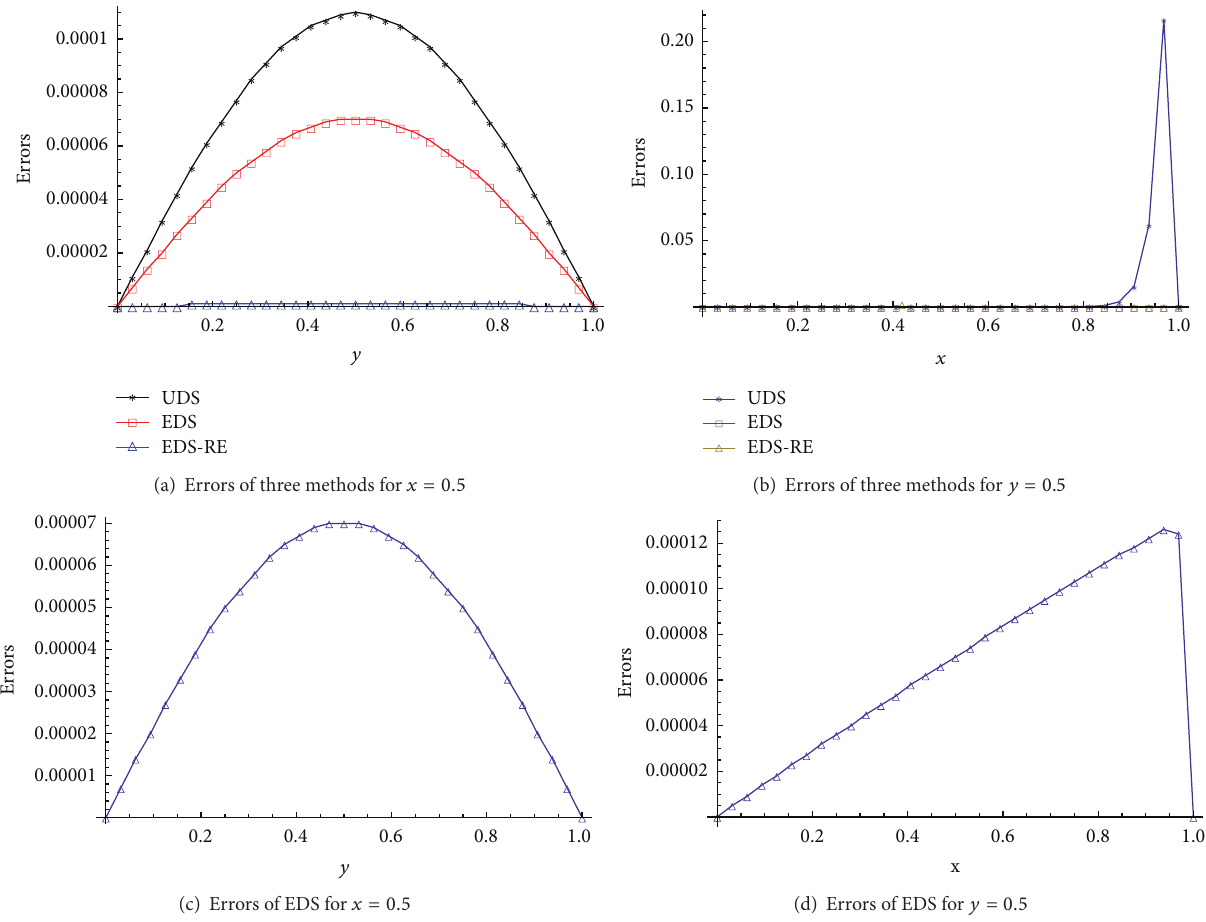
Figure 8: Errors of numerical results, Example 10 with 𝜖 = 0.01, ℎ = 𝑘 = 1/32